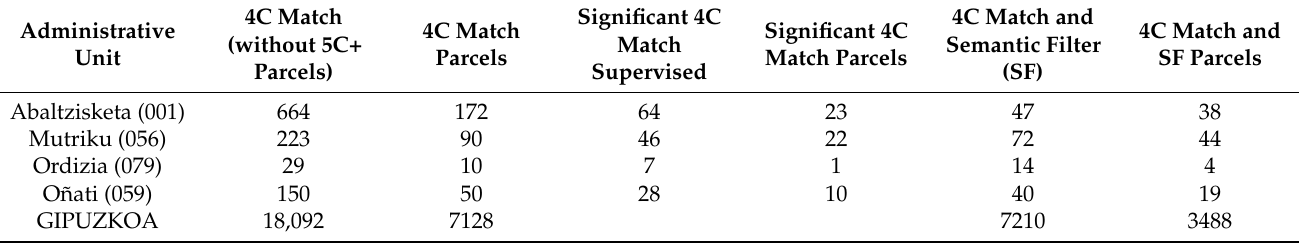
Table 4. Results attained for four-character strings; totals, with supervision and automating the matching with the LKB. Figures are broken down into number of matches and number of